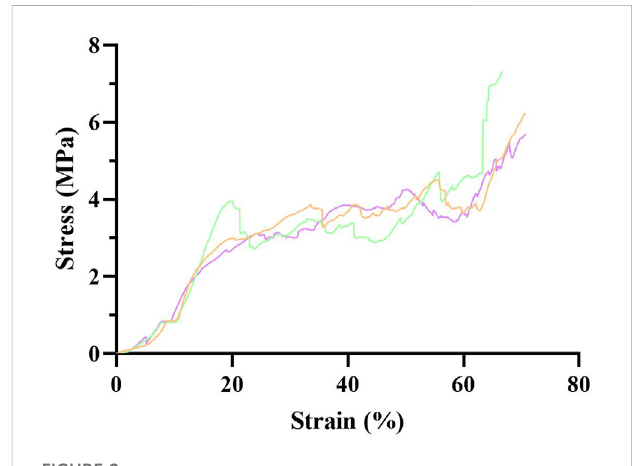
FIGURE 2 Mechanical strength diagram of FDBM (n =